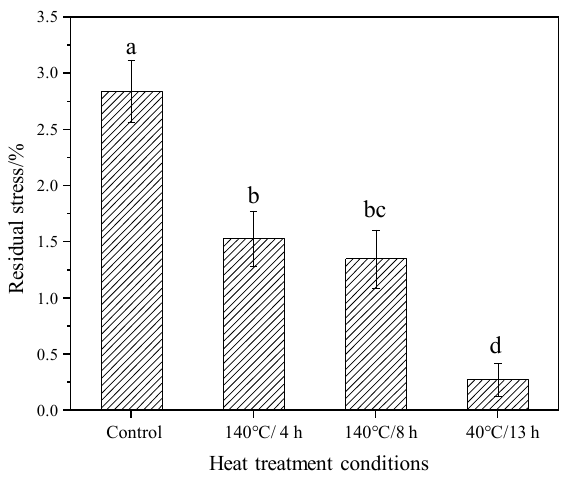
Figure 3. The residual stress of the control and modified wood. Bars with different letters (a, b, bc and d) indicate significant differences ( p < 0.05) according to Duncan’s multiple range tests.